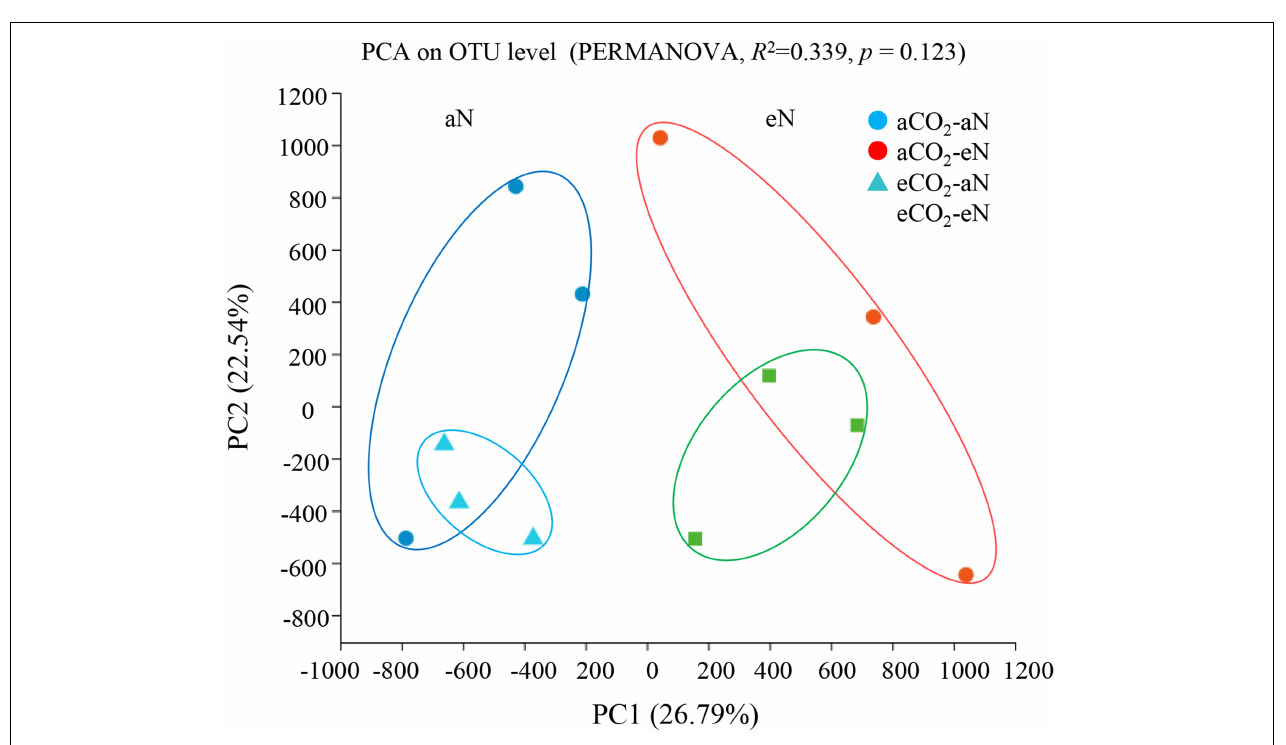
FIGURE 3 | Principal component analysis (PCA) of nifH sequences at the 94% similarity OTU threshold by permutational multivariate analysis of variance (PERMANOVA) test.